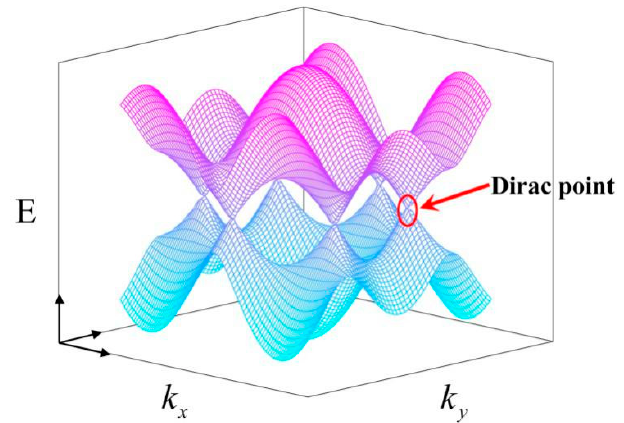
Figure 1. Electron band structure and Dirac point of graphene. Purple represents the n-type doped Fermi surface, and light blue represents the p-type doped Fermi